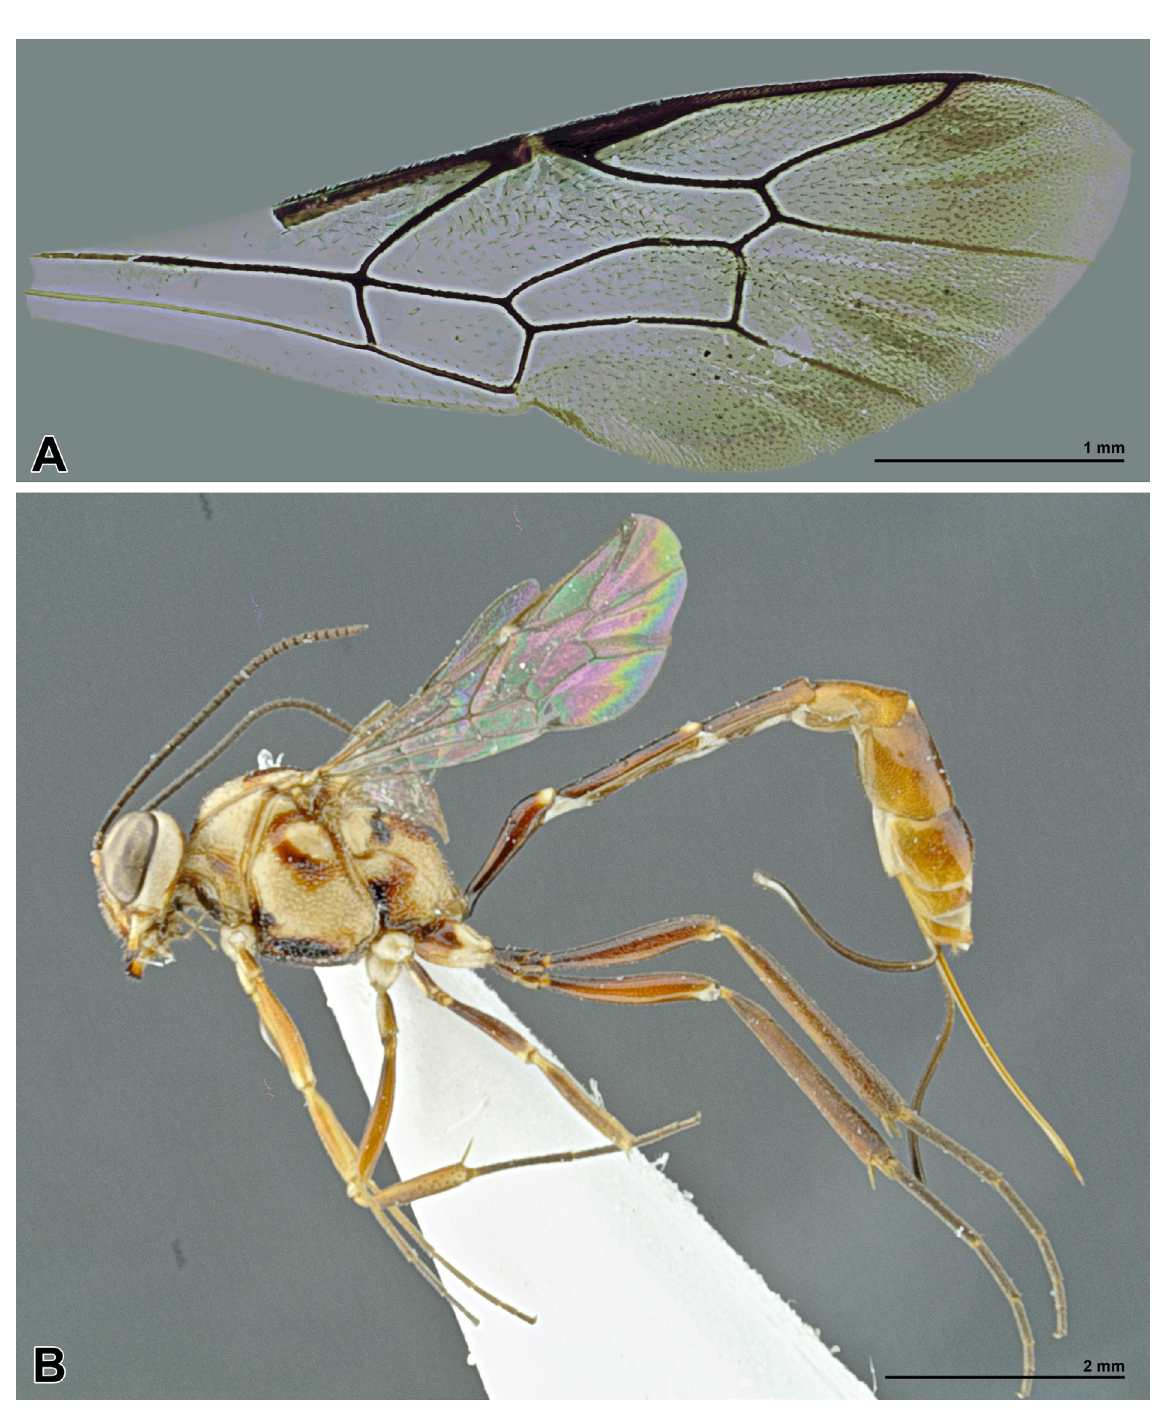
Fig. 5. Anomalon chinense (Kokujev, 1915), ♀, DPPZ. A . Fore wing. B . Habitus, lateral